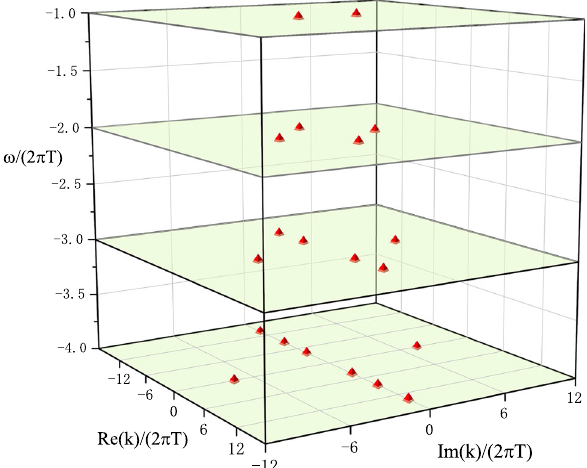
Fig. 5 The pole-skipping points in acoustic black holes from Gross– Pitaeskii equation embedded in curved spacetime near event horizon r 0 ( r 0 = 1)